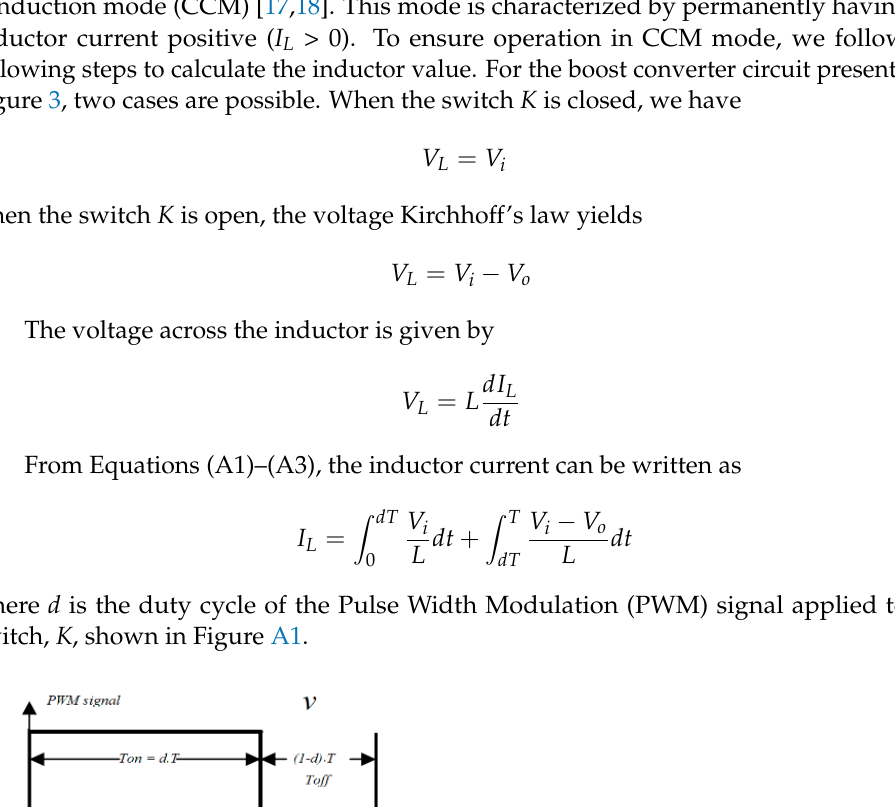
Figure A2. Voltage and current during continuous conduction mode .